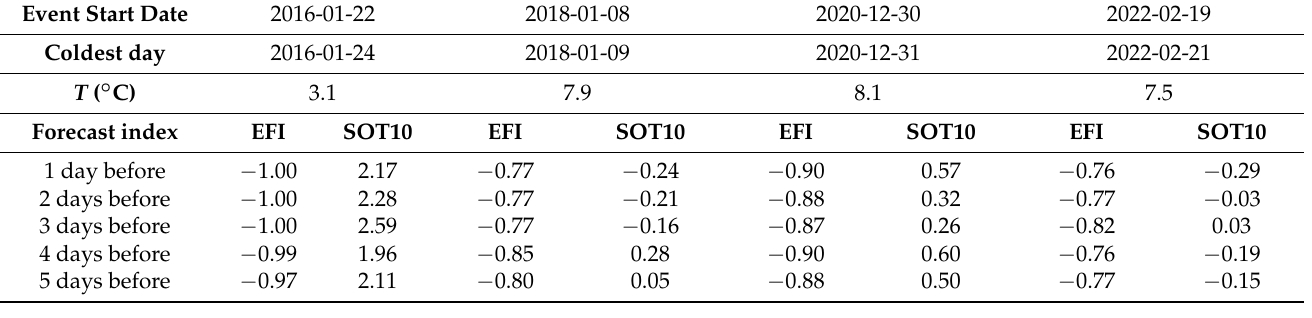
Table 8. ECMWF Extreme Forecast Index (EFI) and Shift of Tail Index for the 10th percentile (SOT10) for 2 m minimum temperature at 00 UTC runs for the coldest day in Hong Kong (00 UTC of the coldest day to 00 UTC of the next day) in recent intense cold events.